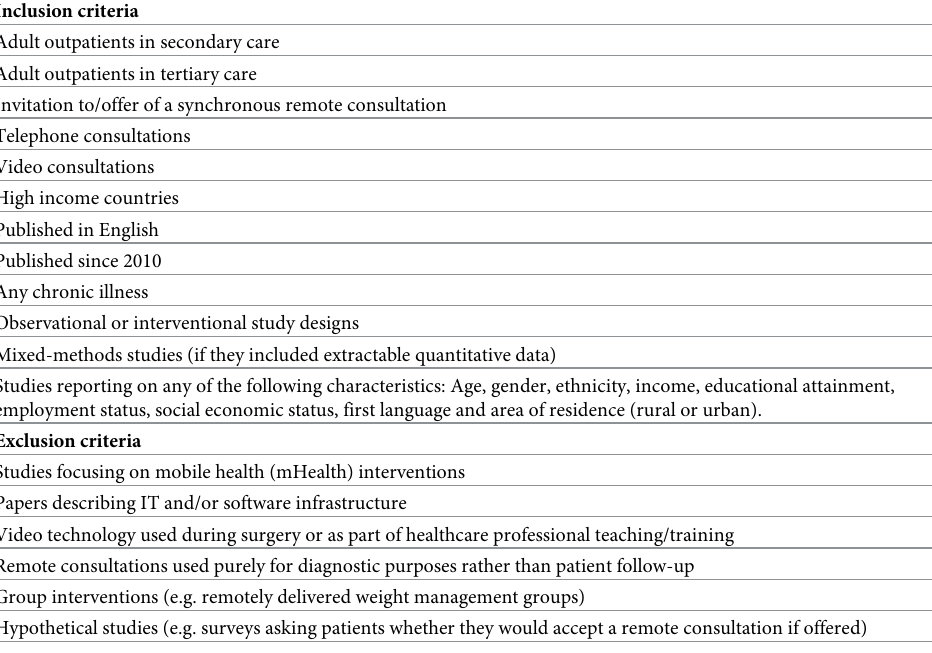
Table 1. Inclusion and exclusion